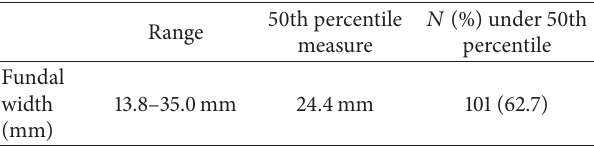
Table 3: Uterine width measured by ultrasound in 165 nulliparous women. Note wide in uterine width as the high number of women with a uterine cavity less than 24 mm